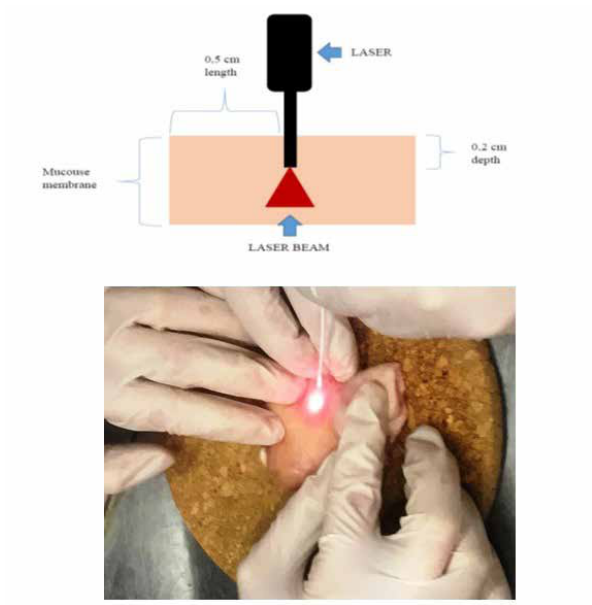
Figure 1: Schematic representation and technique of the